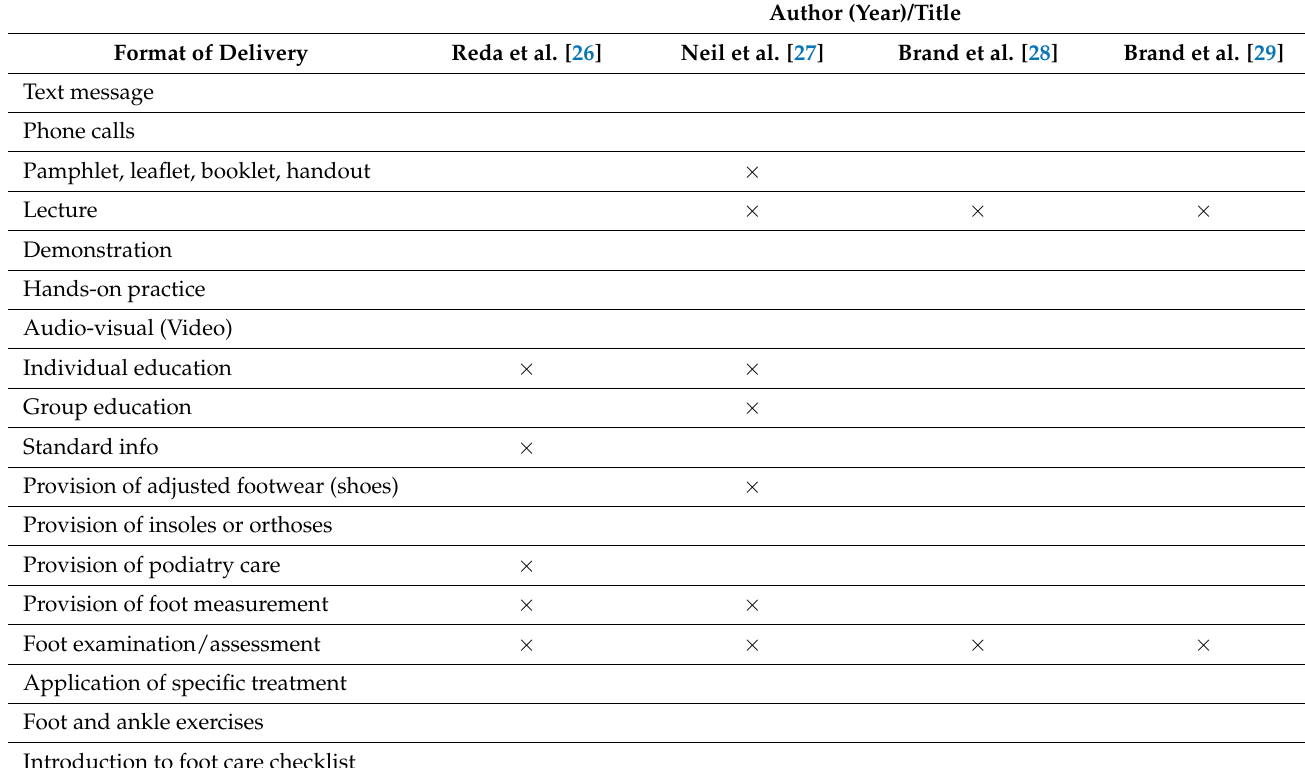
Table 3. Educational foot health intervention structure and delivery